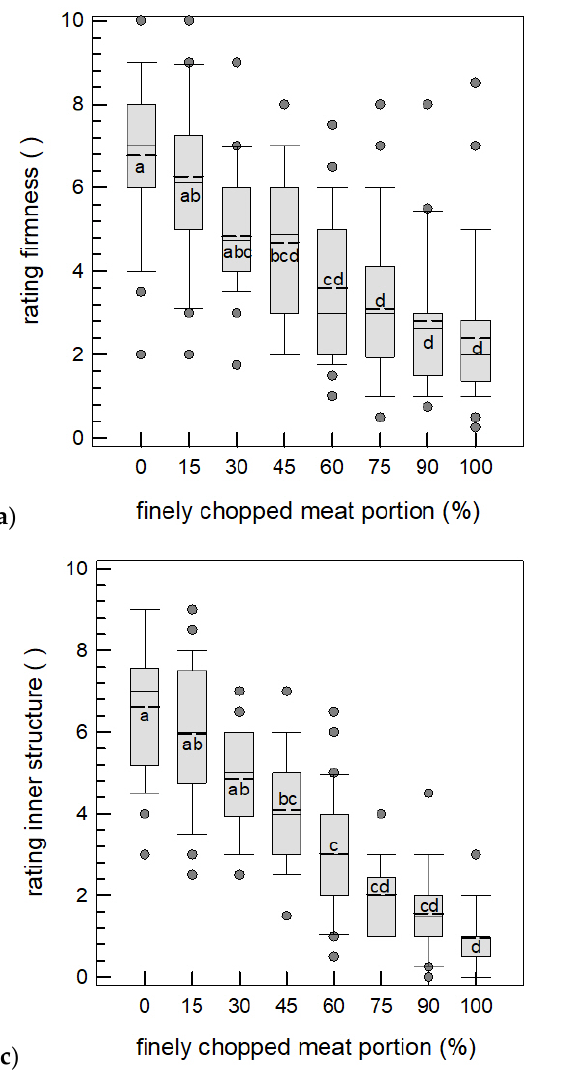
Figure 6. Boxplots of sensory evaluation of ( a ) firmness, ( b ) juiciness, ( c ) inner structure and ( d ) inner cohesion ( n = 30) of cooked meatballs consisting of minced meat with finely chopped meat added; 0 means firm, dry, fine structure, and loose cohesion, whereas 10 means soft, juicy, coarse inner structure, and strong cohesion. Dotted line marks mean full line marks median, box marks lower and upper quartile, and whiskers mark distance until lower and upper extreme and single data points mark outliers. Different letters close to mean emphasize significant differences ( p < 0.05) for each parameter.